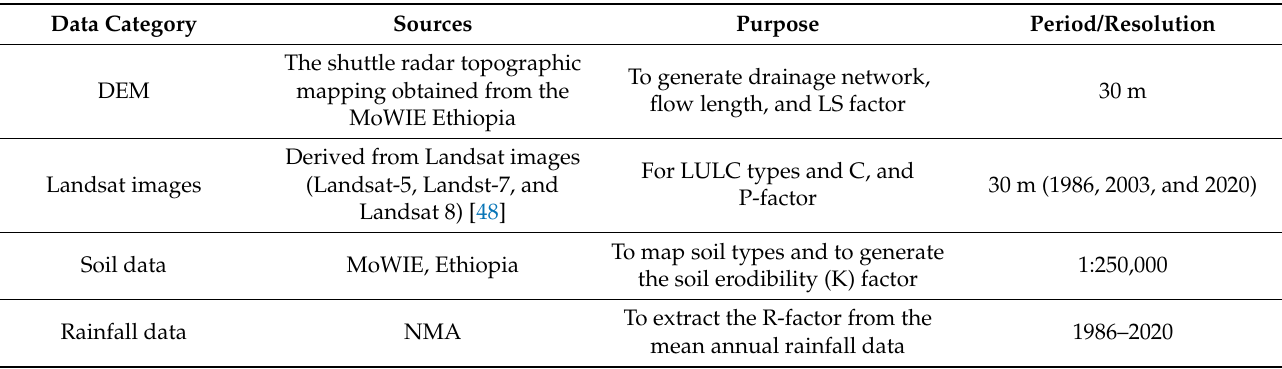
Table 1. Data types and sources.